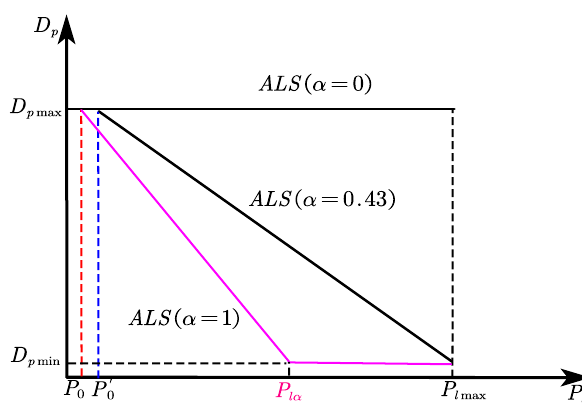
Figure 9. Load-sensitive characteristics for ASL-EHA.